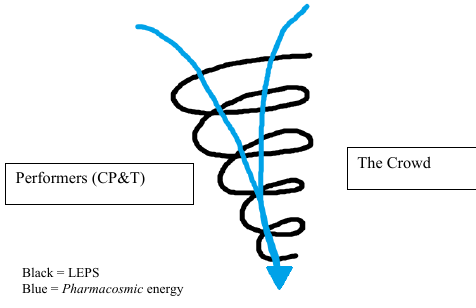
Figure 4. Pharmacosmic power (life force) drawn into liminal space via